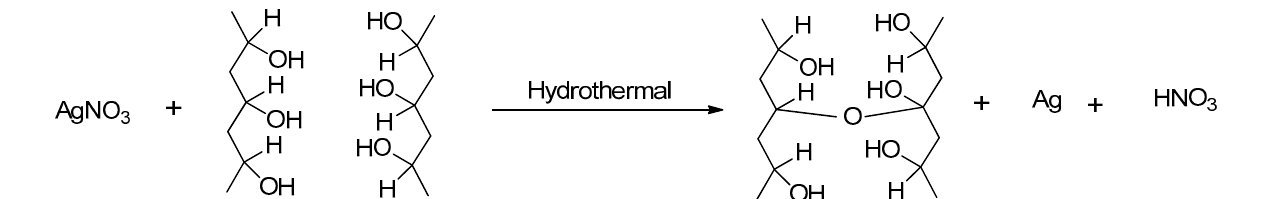
Figure 1. Cross-linking of poly(vinyl alcohol) (PVA) with silver nitrate under hydrothermal conditions.